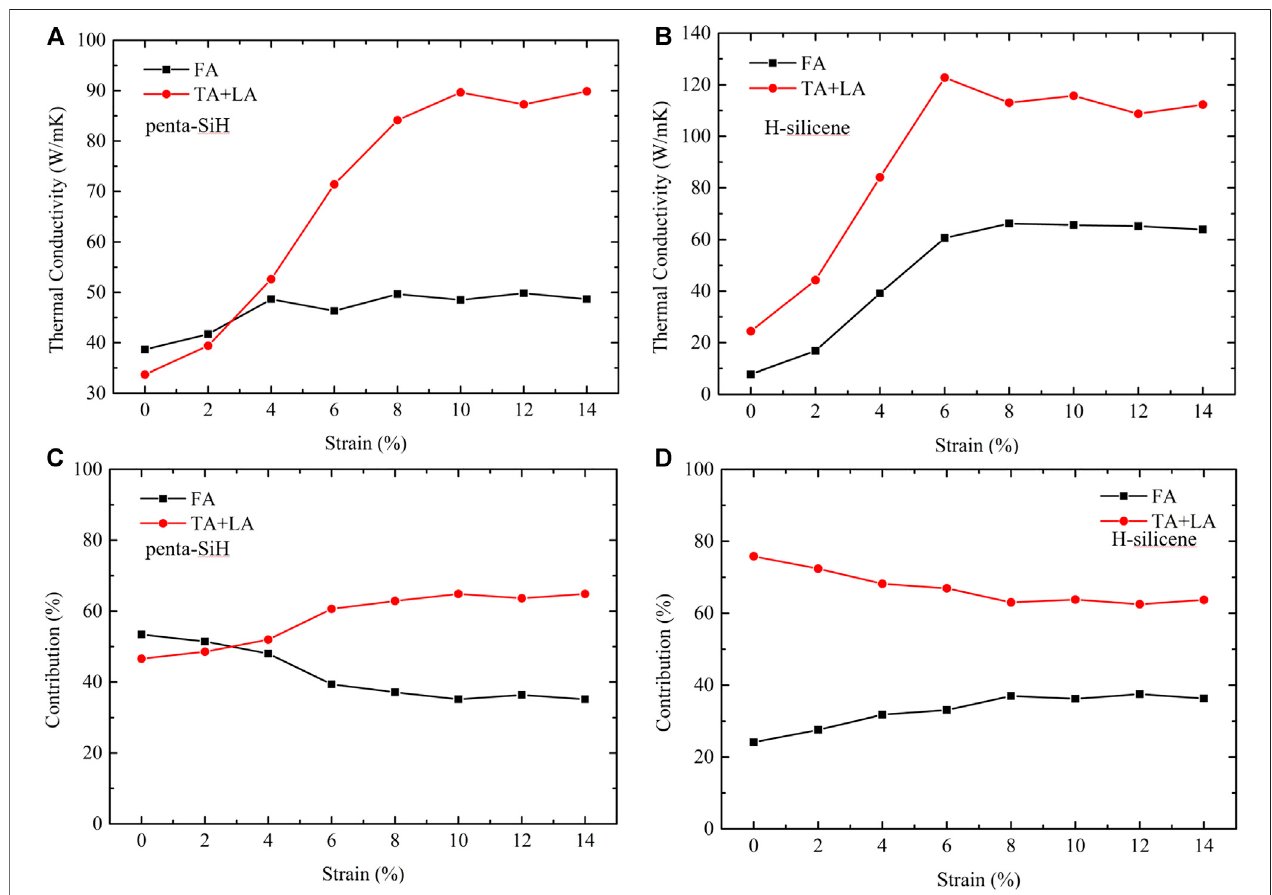
FIGURE6| Thermalconductivitycontributionfromin-plane(TAandLA)andout-plane(FA)acousticphononmodesofpenta-SiH(a,c)andH-silicene(b,d). (A) and (B) The absolute value. (C) and (D) The percentage value.